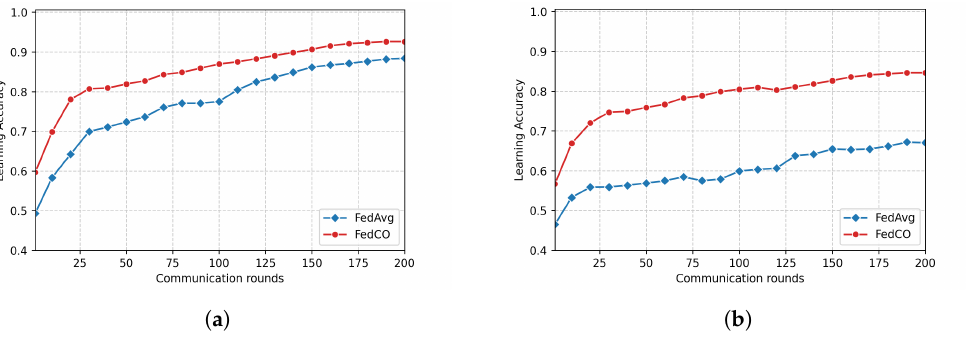
Figure 9. Learning accuracy versus number of communication rounds for CelebA data. The top plot presents the results produced in the case of the IID data distribution scenario, while the bottom plot depicts the results generated in case of the Non-IID data distribution scenario. ( a ) IID; ( b )